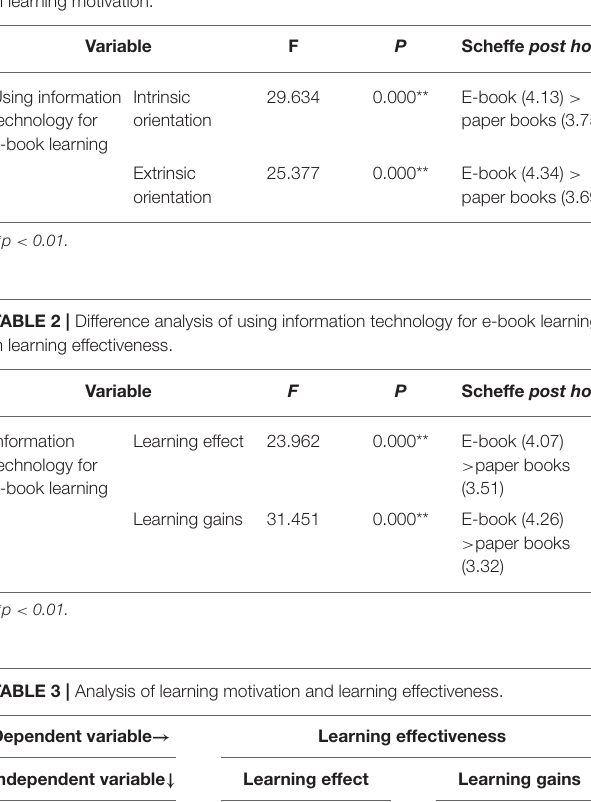
TABLE 1 | Difference analysis of using information technology for e-book learning in learning motivation.